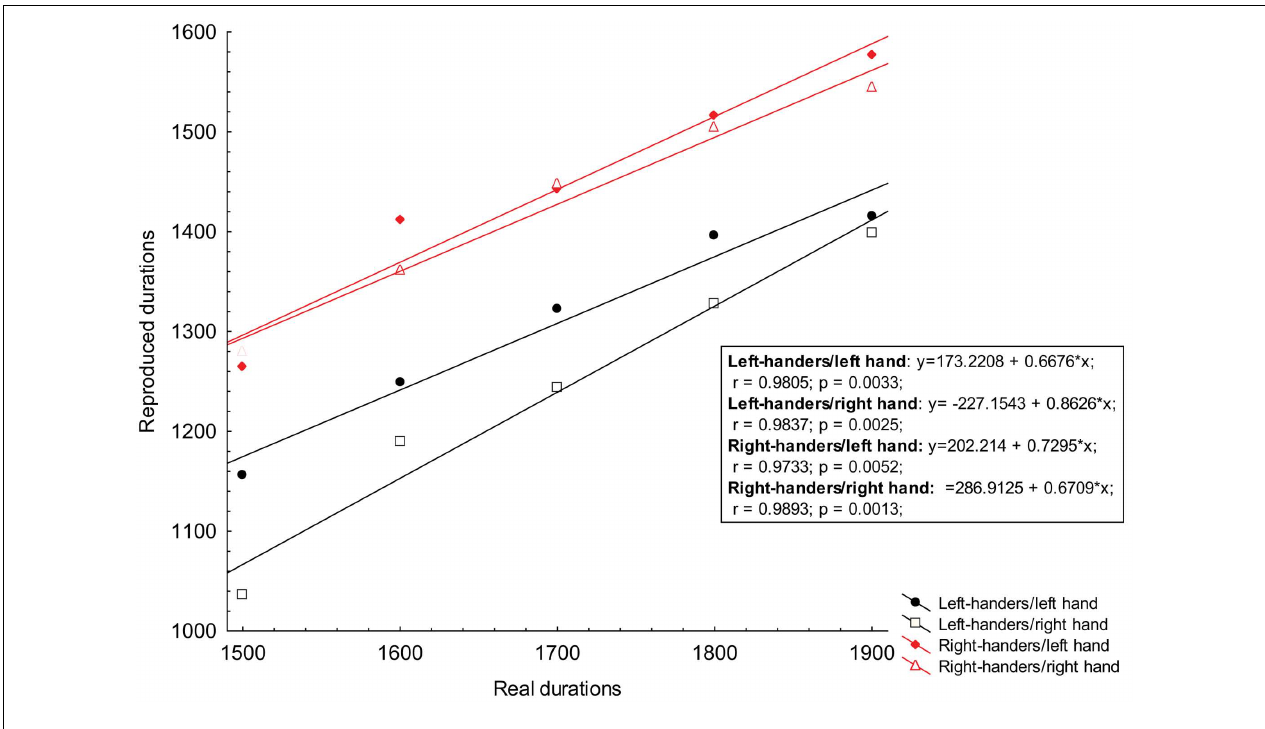
right hand;The abscissa represents the real durations of reference stimuli. Both scores are expressed in milliseconds. Equations derived from each linear regression, correlation, and R square for each condition are displayed in the